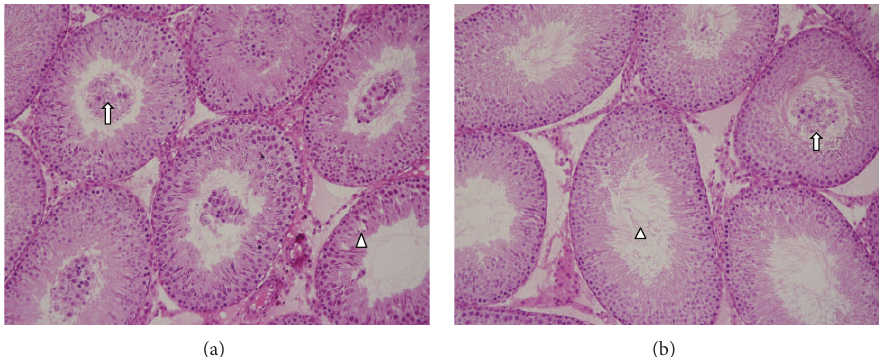
Figure 1: (a) In the MTX group, occasional disorganization in the seminiferous tubule epithelium (arrow head) and immature germinal cells in the seminiferous tubule lumen (arrow). (b) In the MTX + RES group, very few immature germinal cells (arrow) and a very large number of spermatozoa (arrow head) in the seminiferous tubule lumen (H&E × 200).